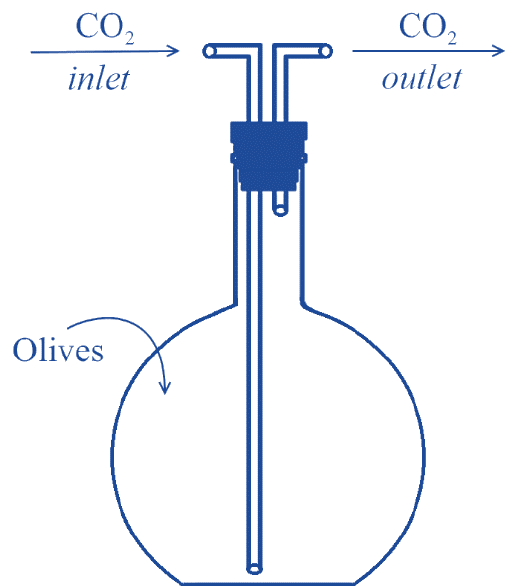
Figure 1. Schematic representation of the glass jar used for the post-harvest treatment of olives. The CO 2 gas was added to the bottom of the glass jar, via a glass tube, to ascertain saturation of the inner of the jar with CO 2 .